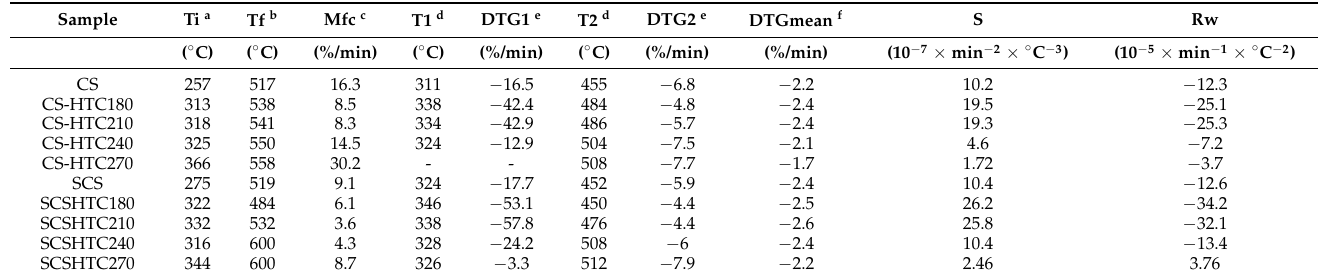
Figure 5. TG-DTG of CS, SCS, and their hydrochar, ( a ) CS and ( b ) SCS. Table 2. Combustion characteristics parameters of CS, SCS, and their